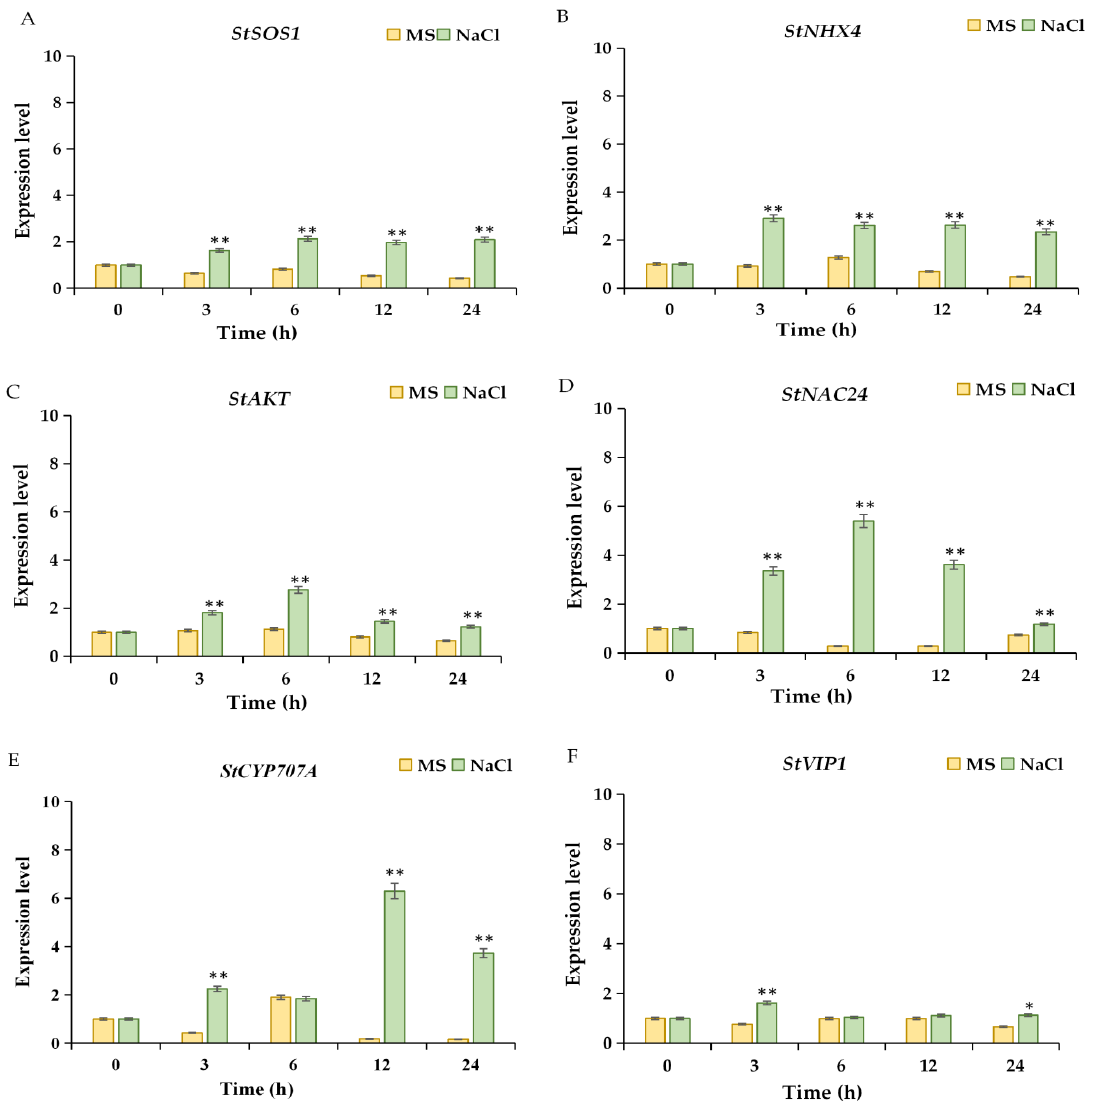
Figure 5. The expression level of ion transport-related genes and transcription factors under NaCl stress within 24 h. MS indicated that potatoes were grown in Murashige and Skoog medium without NaCl stress. NaCl indicated that potatoes were grown in Murashige and Skoog medium with 200 mmol/L NaCl stress. ( A ), ( B ), ( C ), ( D ), ( E ), and ( F ) were the expression levels of StSOS1, StNHX4, StAKT, StNAC24, StCYP707A, and StVIP1, respectively. ** represents a very significant difference. StSOS1, a membranous Na + /H + reverse transporter 1; StNHX4, a possible vacuolar Na + /H + exchanger 4; StAKT, K + transporter; StNAC24, NAC transcription factor 24; StCYP707A, (+)- Abscisic Acid 8′ - Hydroxylase; StVIP1, Vire2-interacting protein 1. In addition, compared with the 0 mmol/L NaCl treatment, the expression levels of StSOS1, StNHX4, StAKT1, StNAC24, StCYP707A , and StVIP1 were significantly increased under NaCl (Figure 6), especially the relative expression levels of StNHX4 and StCYP707A , which were 2.97 and 5.48 times at 150 mmol/L (Figure 6B,E), respectively. These results suggest that ion transport-related genes and transcription factors play an important role in the salt tolerance of ‘Longshu